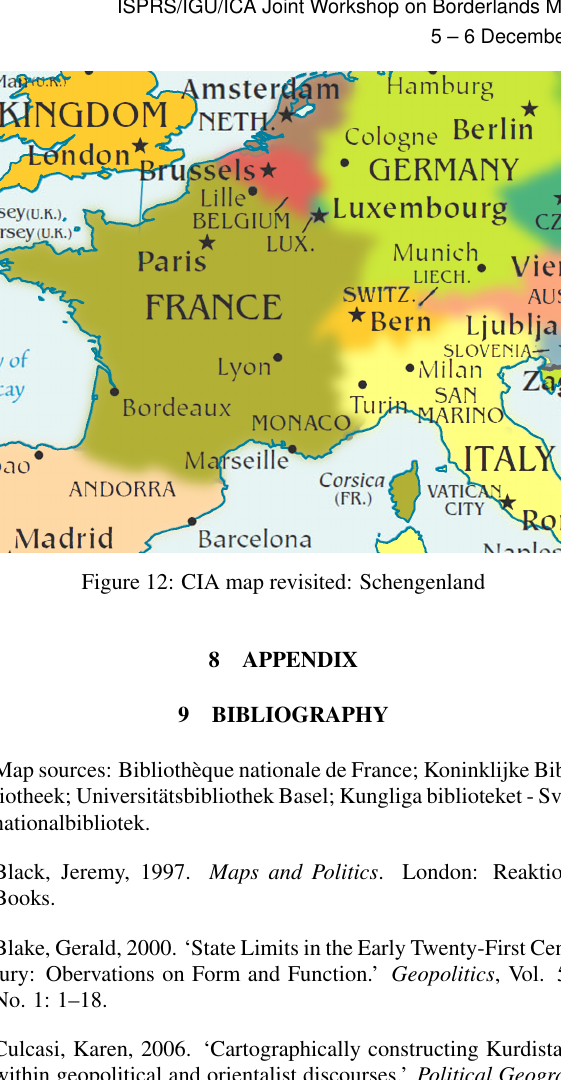
Map sources: Biblioth`eque nationale de France; Koninklijke Bib- liotheek; Universit¨atsbibliothek Basel; Kungliga biblioteket - Sveriges nationalbibliotek.